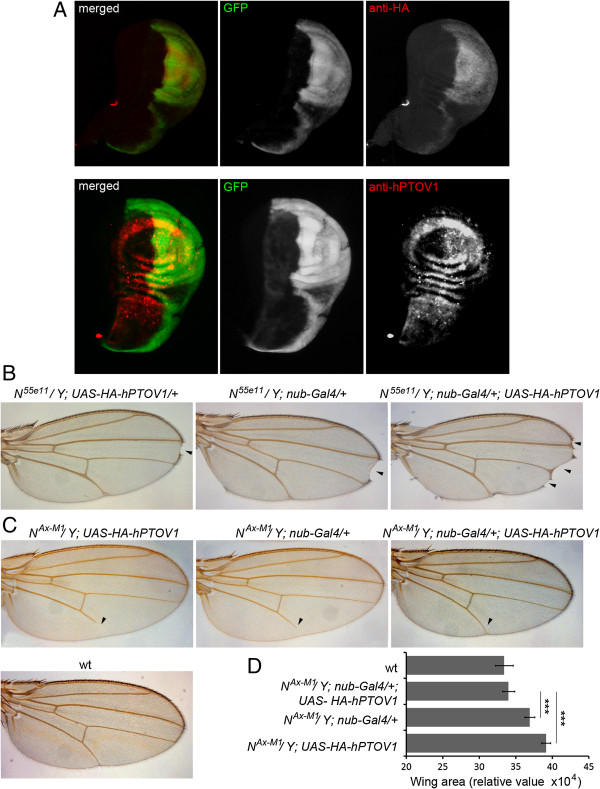
PTOV1 antagonizes Notch activity in the Drosophila wing. (A) Expression of hPTOV1 in engrailed-Gal4UAS-GFP; UAS-HA-hPTOV1 wing imaginal discs. To confirm the activity of the transgene, the ectopic expression of hPTOV1 from the UAS-HA-hPTOV1 was examined. The engrailed-Gal4 line, which drives UAS-transgene expression only in the posterior compartment of the wing disc, allows to compare the levels of expression in anterior versus posterior compartments in the same tissue (imaginal disc). The expression of the transgene was observed by (1) co-activation of a UAS-GFP, (2) immuno detection of HA and (3) antibodies to PTOV1. Absence of staining in the anterior (left) half of the disc contrasts with positive staining in the posterior (right) half, demonstrating the ectopic expression of PTOV1 driven by engrailed-Gal4. (B) Overxpression of hPTOV1 exacerbates the effects of loss-of-function (LOF) of Notch. Notch LOF allele N55e11 causes a notch at the wing edge (arrowhead, left and middle panels) that is exacerbated by expression of hPTOV1 (arrowheads, right panel). (C) Expression of hPTOV1 suppresses the effects of Notch gain-of-function (GOF). The GOF Notch allele NAx-M1 causes defects in the L5 vein (arrowhead, left and middle panels), suppressed by expression of hPTOV1 (arrowhead, right panel). A wild type (wt) wing is shown as control. (D) Histogram showing the quantification of the wing areas for each genotype (n > 30) (*** p < 0.0005).